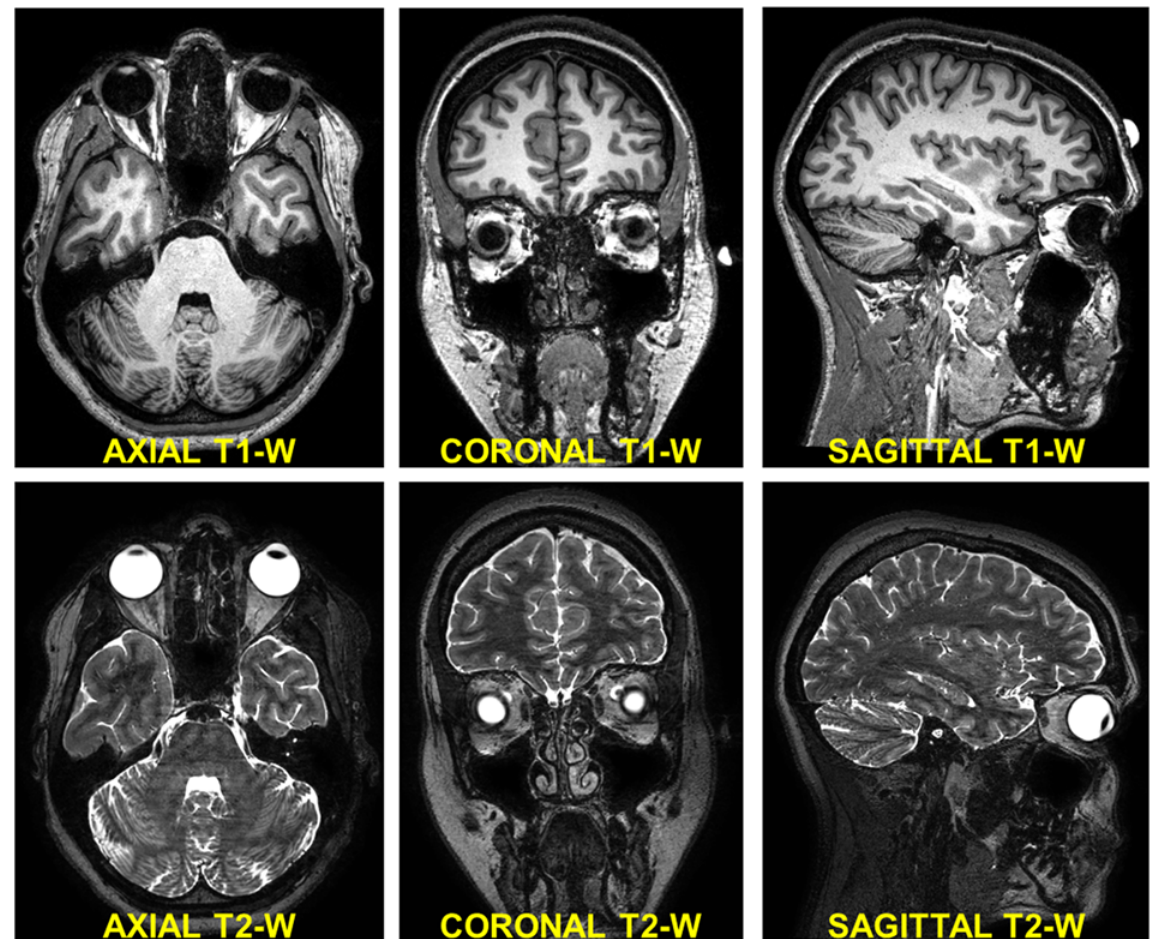
Fig 1. Structural MRI scans used for segmentation. Axial (left), coronal (middle), and sagittal (right) views of the T1- (top) and T2-weighted (bottom) structural MRIs. A specific T2-weighted MRI sequence with high nerve contrast optimized to enhance the structures of the ear and eye was also acquired (data not